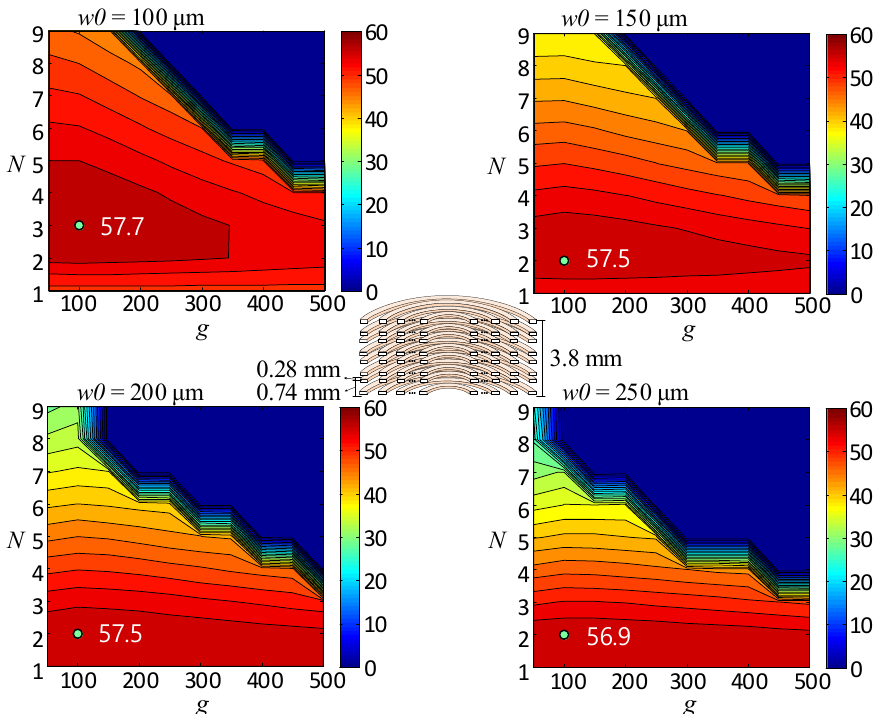
Figure 14. The calculated maximum coupling efficiency (%) according to g and N for the eight-layer planar spiral coil for w 0 = 100, 150, 200, and 250 μ m.